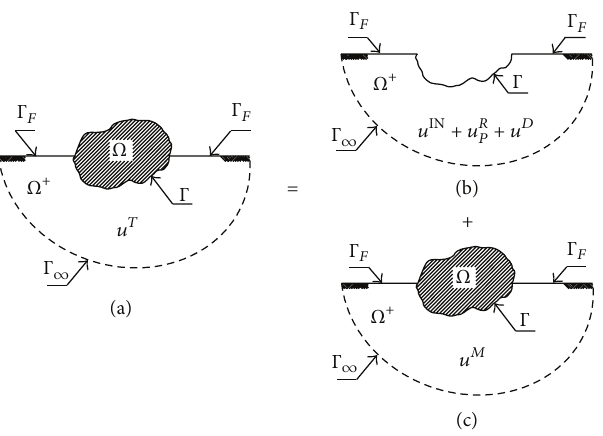
Figure 1: Partition of the total domain into subdomains. The total problem is divided into a generalized supporting half-space of domain Ω + and a scatterer of domain Ω . The solution for the generalized half-space is constructed by the addition of an optical field 𝑢 IN + 𝑢 𝑅 𝑃 plus its diffractions 𝑢 𝐷 over the irregularity Γ .